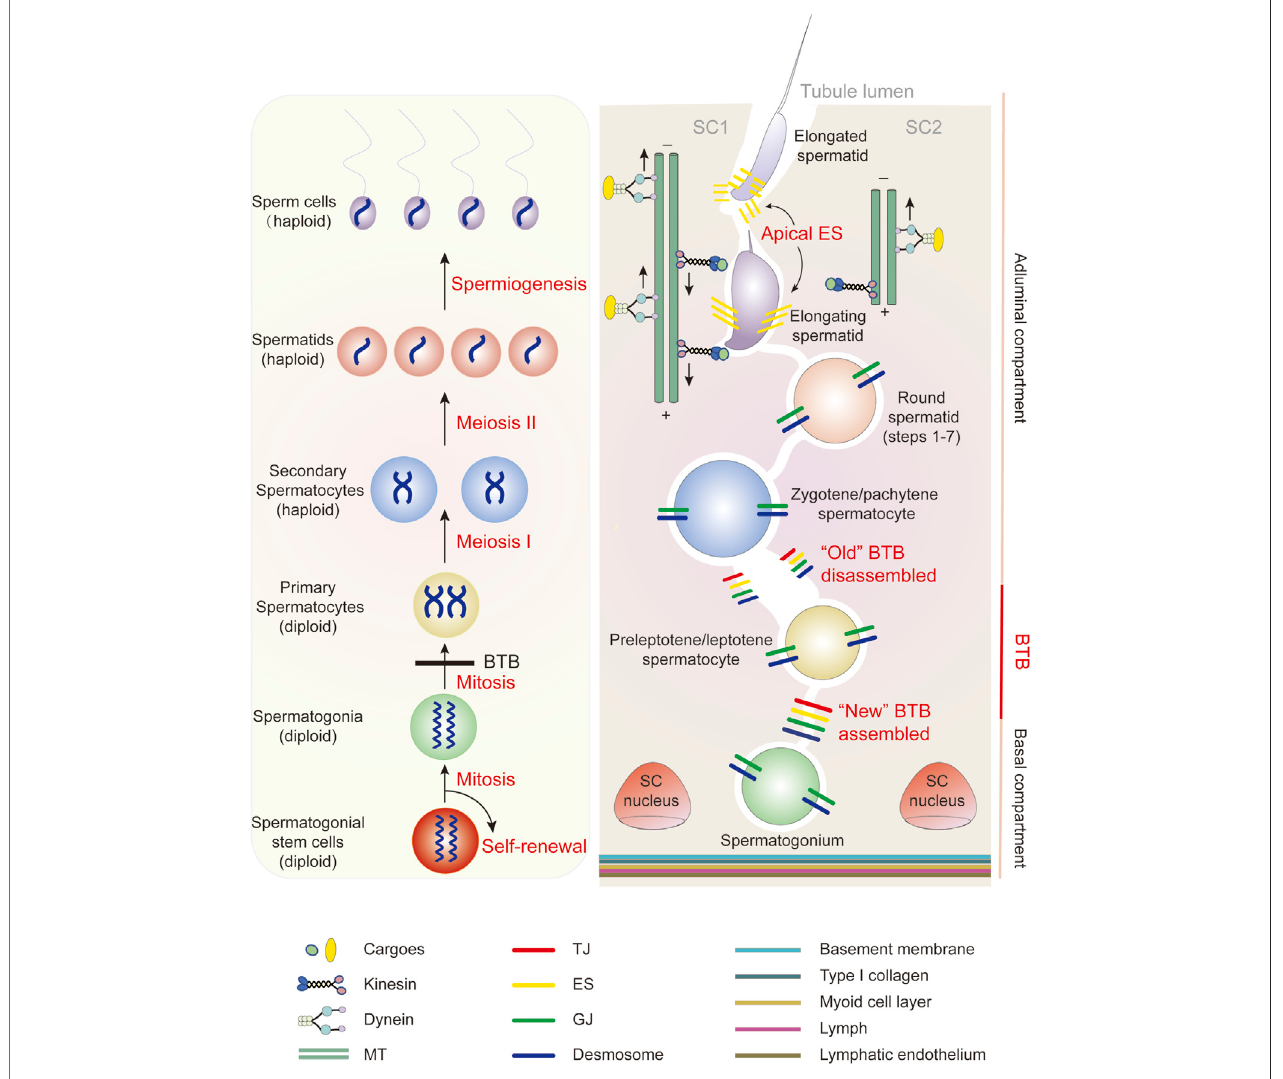
FIGURE 3 | (Left) A diagram depicting the cell cycle progression and different germ cell types during spermatogenesis. (Right) A schematic drawing that illustrates the cross section of the seminiferous tubule in the rat testis. Four types of Sertoli cell-cell junctions at the blood-testis barrier (BTB), namely tight junction (TJ), basal ectoplasmic specialization, gap junction (GJ), and desmosome, as well as cell-cell junctions at the Sertoli-germ cell interface are illustrated. Spermatogonia, spermatocytes, and steps 1 – 7 round spermatids are connected to Sertoli cells via GJ/desmosome. More advanced spermatids (steps 8 and later) are connected to Sertoli cells via apical ectoplasmic specialization. The BTB, which is created by two adjacent Sertoli cells, divides the seminiferous epithelium into two compartments: adluminal and basal. At stage VIII of the epithelial cycle, the “ new ” BTB forms before the “ old ” BTB disassembles to allow the transport of preleptotene/leptotene spermatocytes. Also, near the seminiferous tubule lumen, apical ectoplasmic specialization disassembles to release the elongated spermatids during spermiation. The apicalectoplasmicspecializationishypothesizedtobeassociatedwithmicrotubule(MT)-basedmotors(kinesinsanddyneins)thatallow “ downandup ” movementinthe apical seminiferous epithelium of maturing